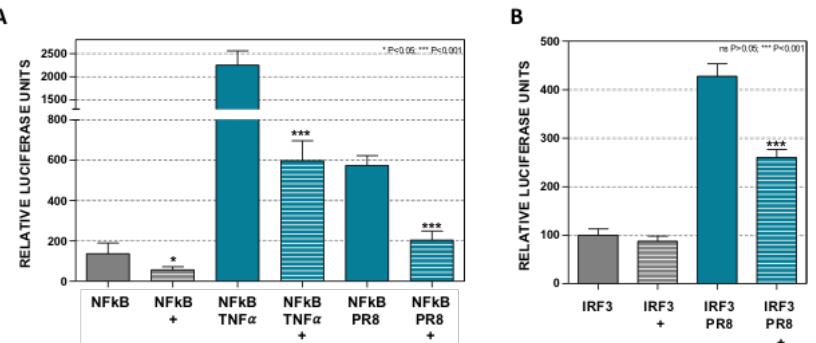
Figure 2. Dot1L controls NF- κ B and IRF3 activation. A549 cells were left untreated or treated with 1 μ M EPZ (+), 48 h later the cells were ( A ) transfected with a plasmid expressing luciferase under the NF- κ B promoter (NF- κ B) and at 24 hpt they were stimulated with TNF- α β 20 ng / mL, NF- κ B-TNF α ), or infected with influenza virus (PR8, MOI 1, NF- κ B-PR8), and the luciferase activity was evaluated at 16 h later; ( B ) transfected with reporter plasmid p55-IRF3 expressing luciferase under the IRF3 promoter, and the luciferase activity was evaluated 16 h later. In all cases, the luciferase activity values were normalized by Renilla luciferase and they were expressed relative to their corresponding EPZ untreated control conditions. Three technical replicates of three independent experiments were analyzed. ns p > 0.05; * p < 0.05; ** p < 0.01; *** p < 0.001.